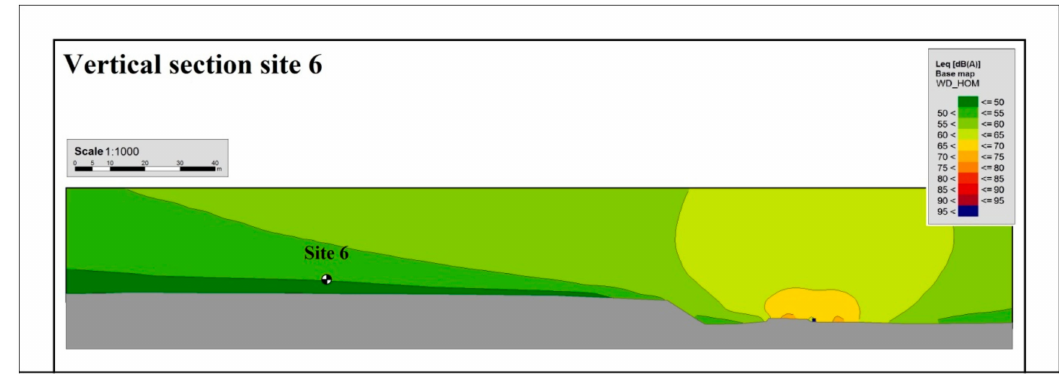
Figure 13. Terrain vertical section corresponding to Site 6. Soil characteristics: uncultivated field and above-ground with respect to the GRA. Equivalent level intervals are displayed with di ff erent colors. Levels calculated according to the Basic Noise Map WD_HOM.